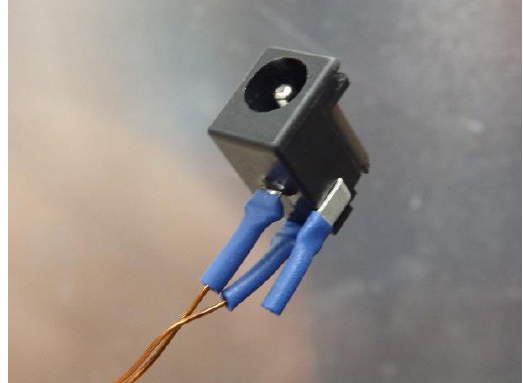
Figure 2. Barrel jack connections and covering.